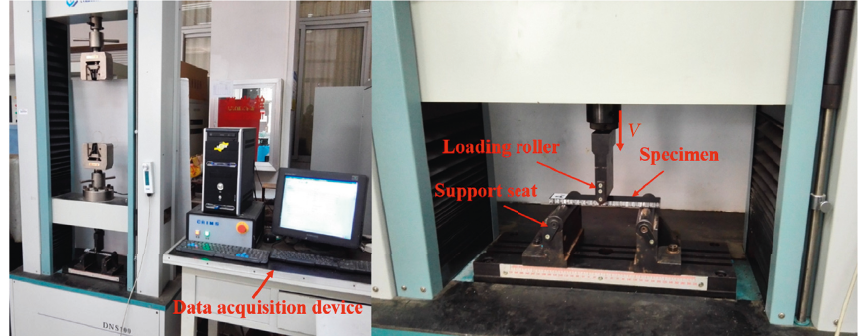
Figure 7: Specimens tested in the electronic universal testing machine.